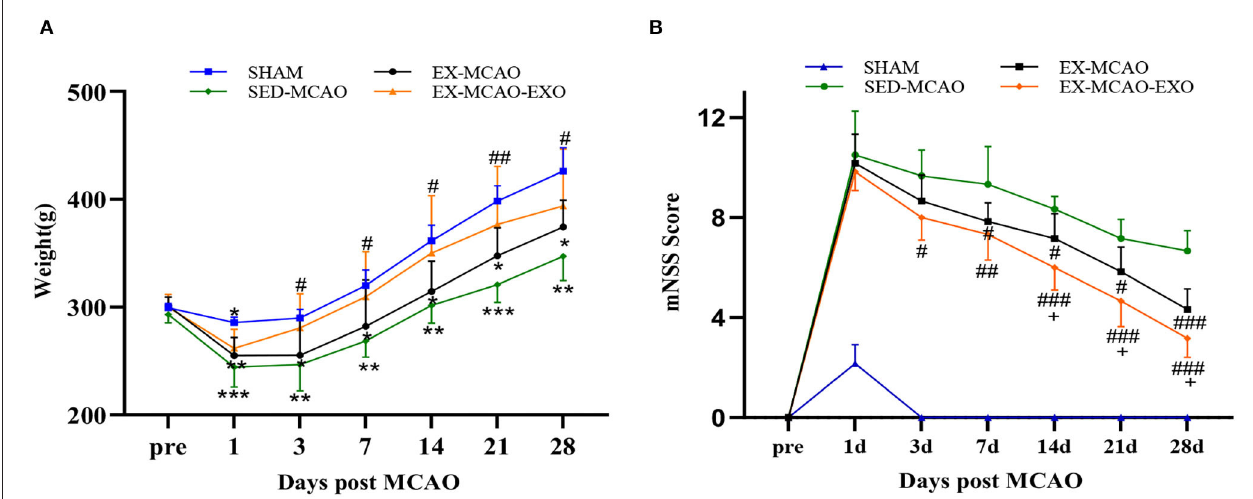
FIGURE 2 | Survival status and mNSS scores of the MCAO rats. (A) Weight changes in the rats. (B) Changes in behavioral scores of the rats. * P < 0.05, ** P < 0.01, and *** P < 0.001 compared with the SHAM group; # P < 0.05, ## P < 0.01, and ### P < 0.001 compared with the SED-MCAO group; + P < 0.05 compared with the EX-MCAO group. Mean ± standard deviation. N =